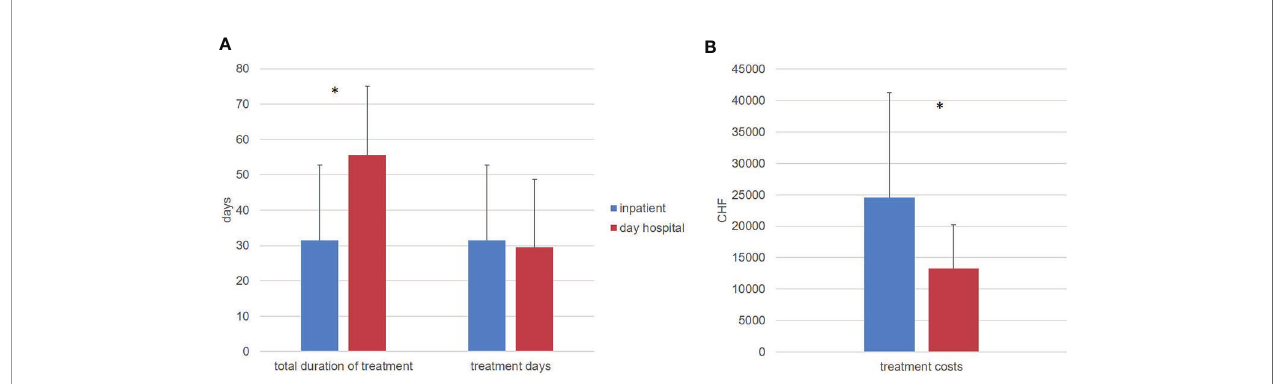
FIGURE 3 | (A) total duration of treatment in days and treatment days (means and standard deviation). (B) direct treatment costs in swiss franc (CHF) (means and standard deviation), *signi fi cant difference (p